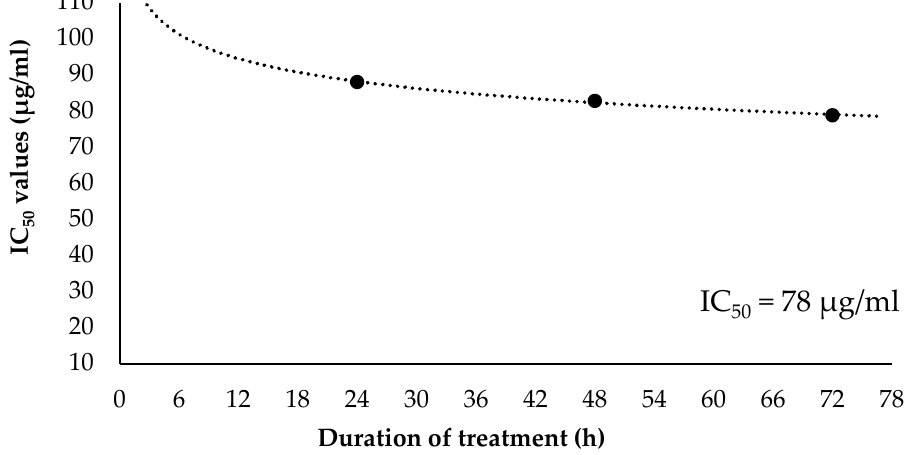
Figure 5. Determination of constant IC 50 value of EO-L in PANC-1 cell line. The constant IC 50 value of EO-L was also determined in BEAS-2B non-cancerous cell line. In these cells, IC 50 values obtained at 24 h, 48 h and 72 h were 80 µg/mL, 90 µg/mL and 96 µg/mL, respectively (Figure 6). The plot in Figure 6 indicates that the IC 50 values of EO-L gradually increase with a prolonged incubation period in BEAS-2B non-cancerous cells. The constant IC 50 value of EO-L in BEAS-2B cells was determined to be 96 µg/mL.